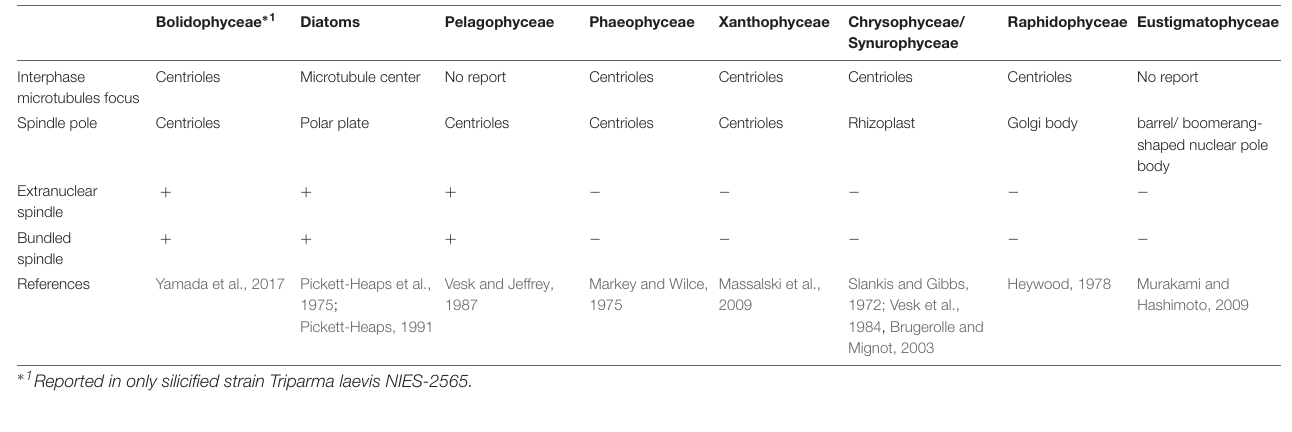
TABLE 3 | Mitotic characters of Stramenopiles.